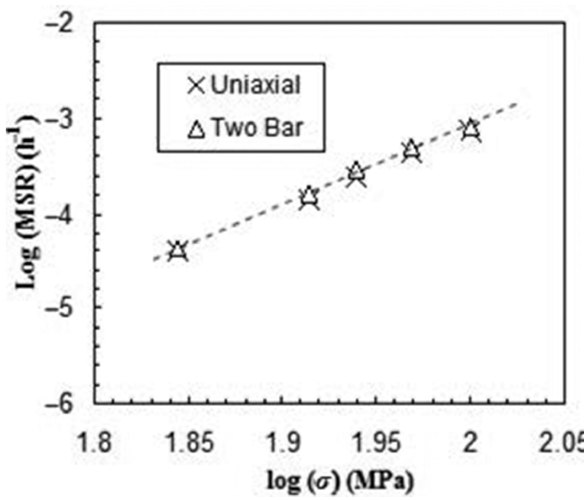
Figure 17: Minimum creep strain rate data for grade P91 steel at 650 ° C, uniaxial and TBS.